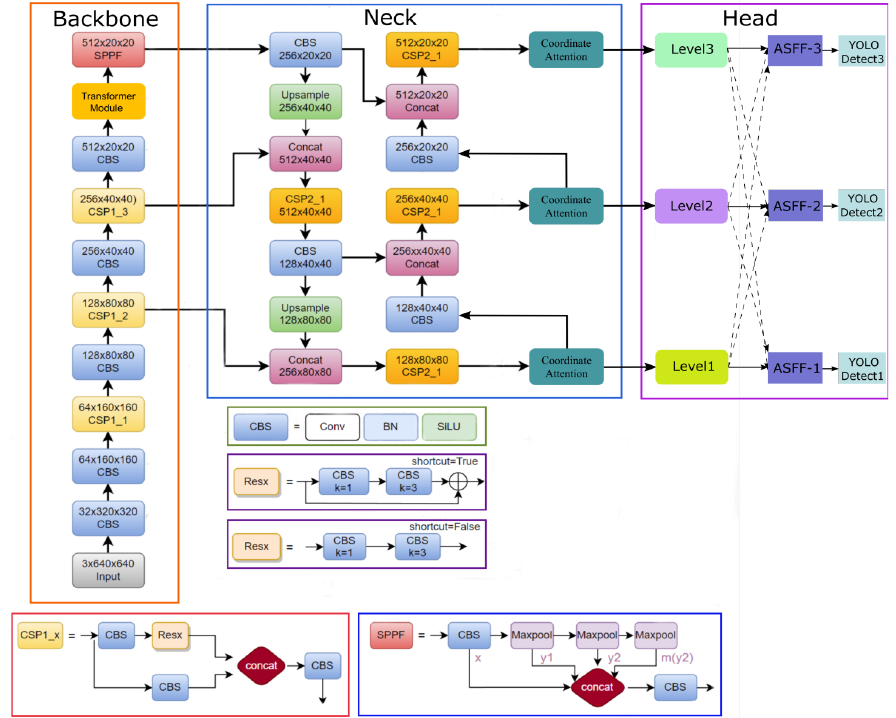
Figure 7. The general framework diagram of the proposed forest fire target detection model, TCA-YOLO.